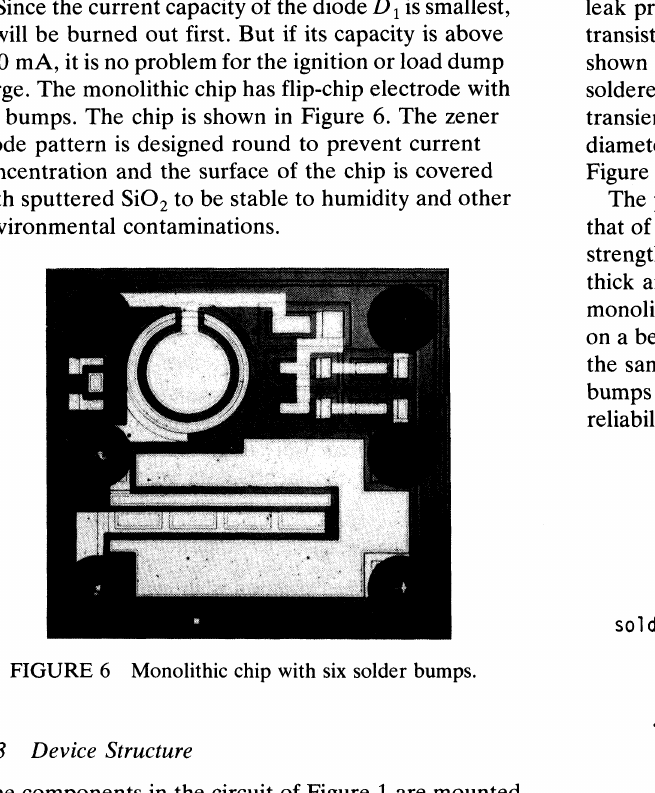
FIGURE 6 Monolithic chip with six solder bumps.